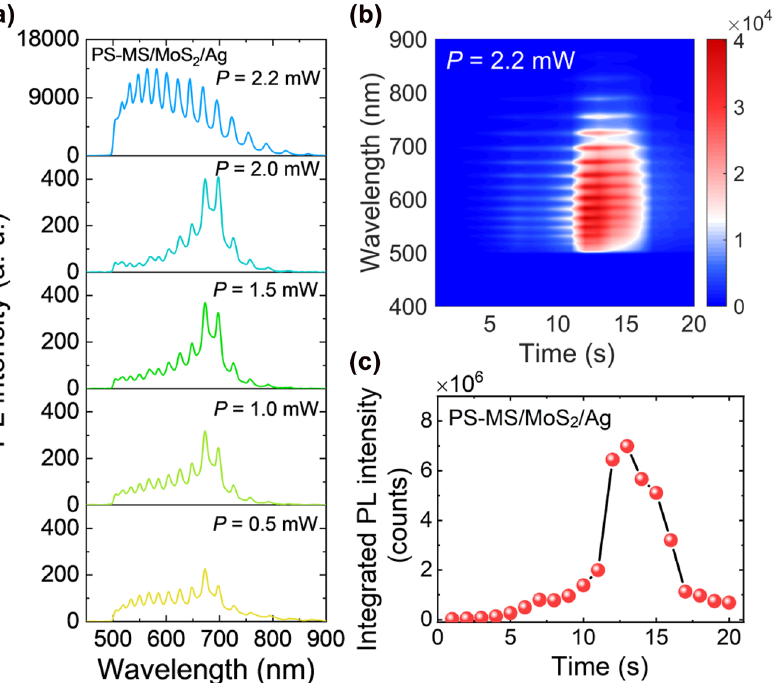
/Ag microcavity by laser irradiation. (a) PL spectra measured for a PS-MS/MoS 2